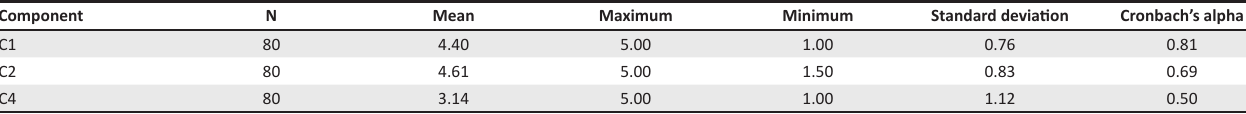
TABLE 4: Descriptive statistics and Cronbach’s alpha coefficient. Component